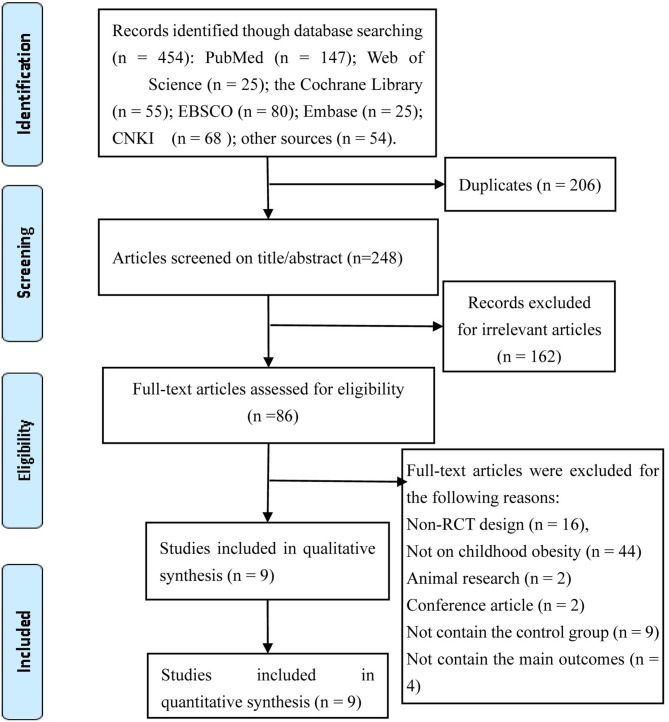
Selection process of eligible studies.